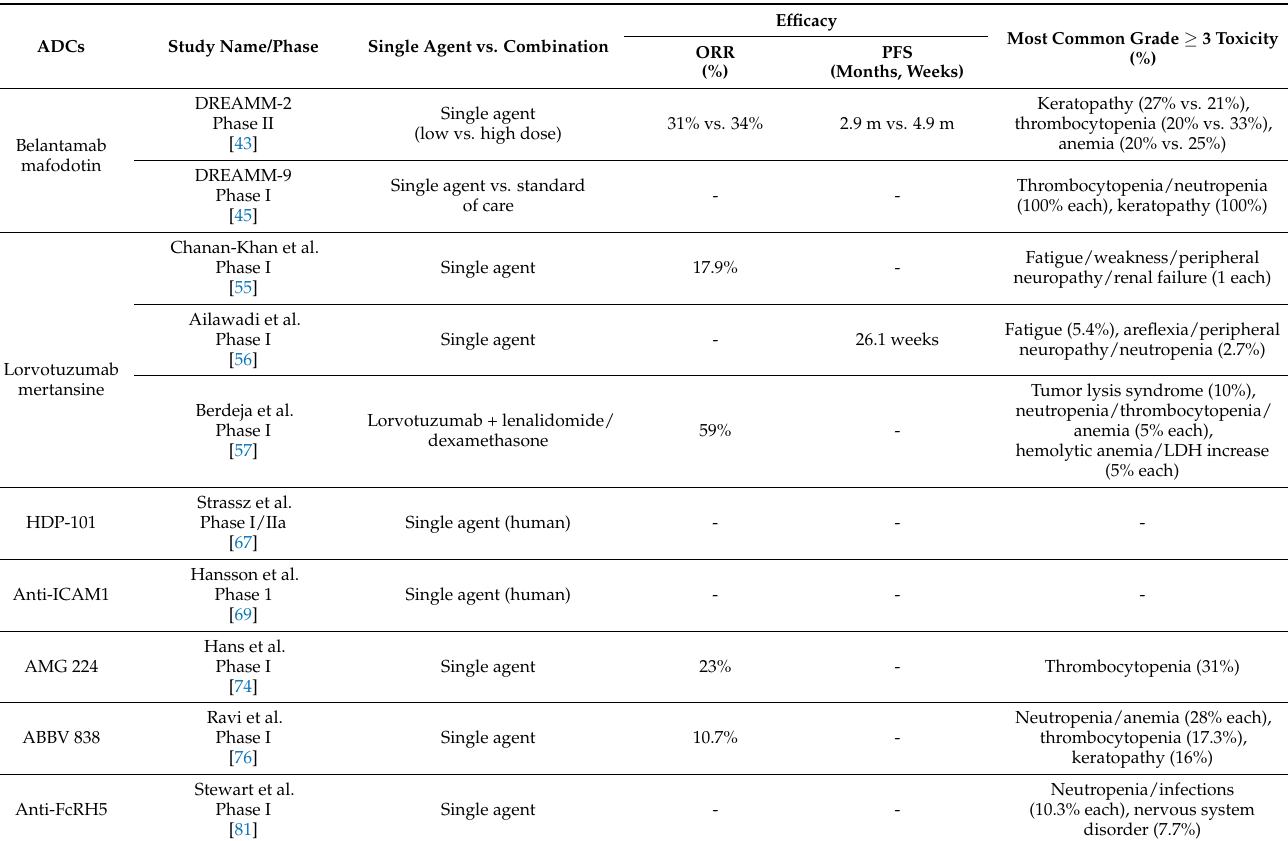
Table 2. Antibody drug conjugates summary of efficacy and grade 3 adverse events for treatment of multiple